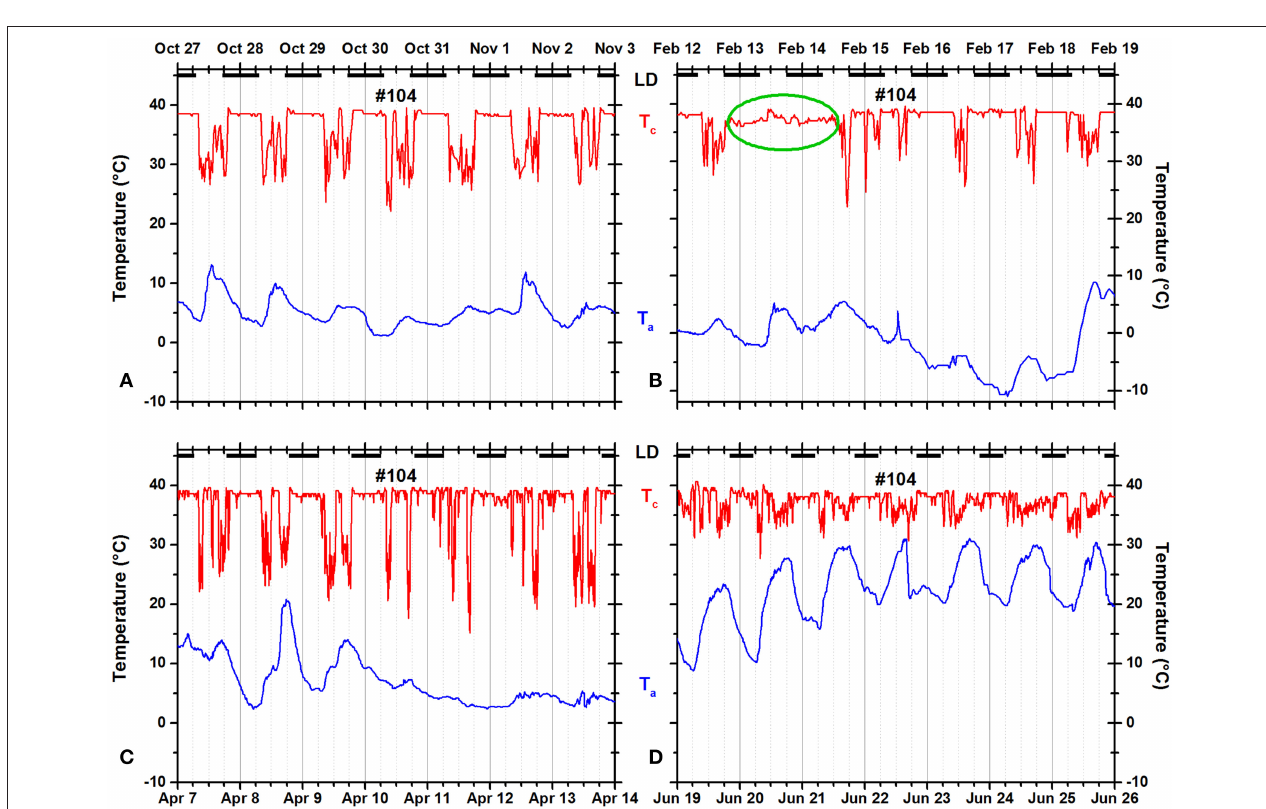
FIGURE 9 | Records of ambient temperature (T a , blue) and neck skin temperature (T c , red) for fox squirrel #104 in (A) fall, (B) winter, (C) spring, and (D) summer. The dark horizontal bars at the top of each panel indicate the duration of the dark phase of the natural light–dark cycle. The green oval in (B) marks a day when the squirrel did not leave its insulated